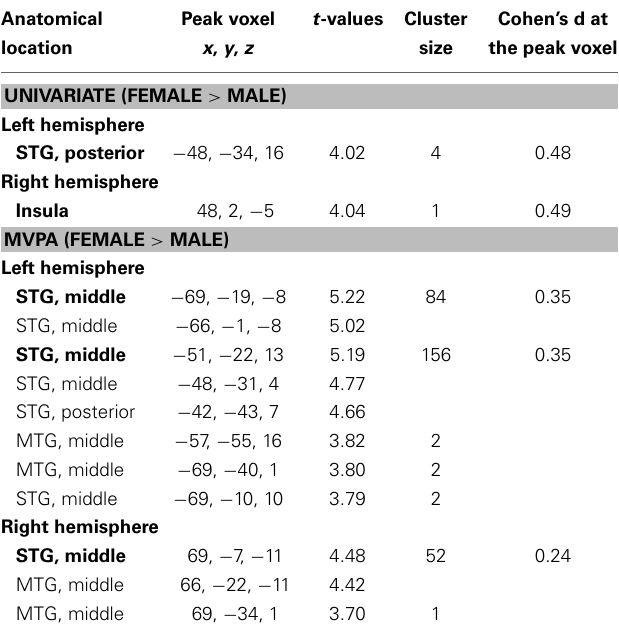
Table 3 | Peak voxels of female > male contrast for univariate analysis and